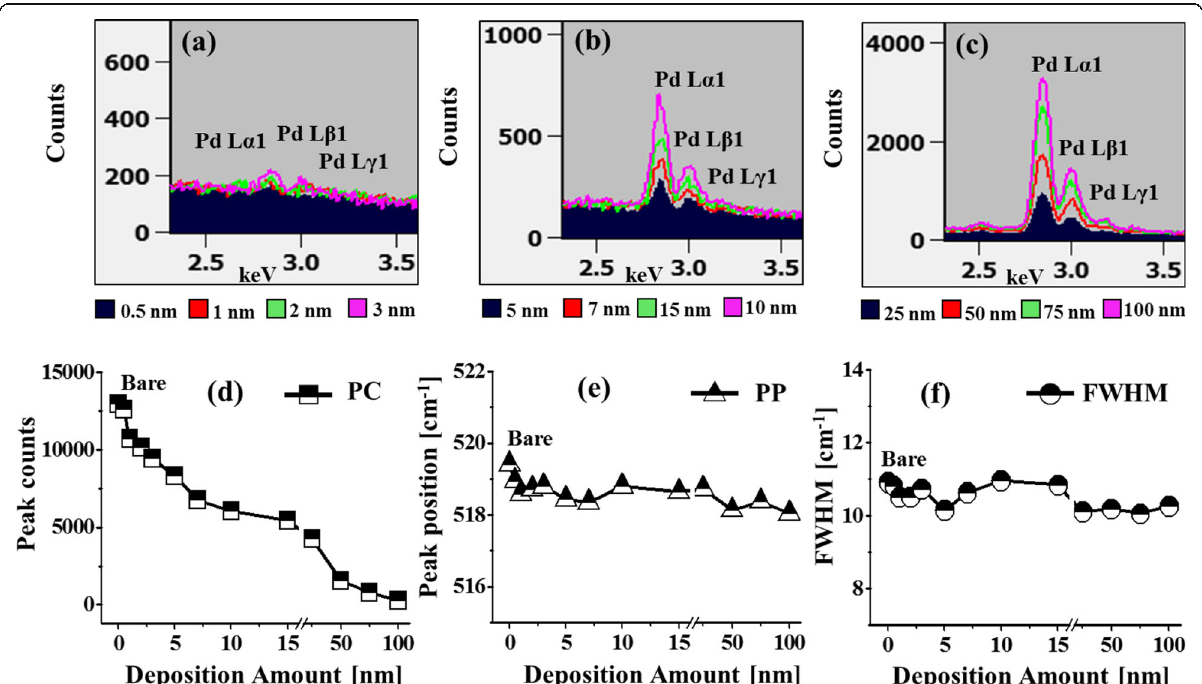
Fig. 3 a – c Energy-dispersive X-ray spectroscopy (EDS) spectra of the samples with various Pd deposition amount between 0.5 and 100 nm after annealing at 575 °C for 450 s. Raman summary plots of d peak counts ( PC ), e peak position ( PP ), and f full width at half maximum ( FWHM ) as function of deposition amount between 0.5 and 100 nm. The full-range Raman spectra are shown in Additional file 1: Figure